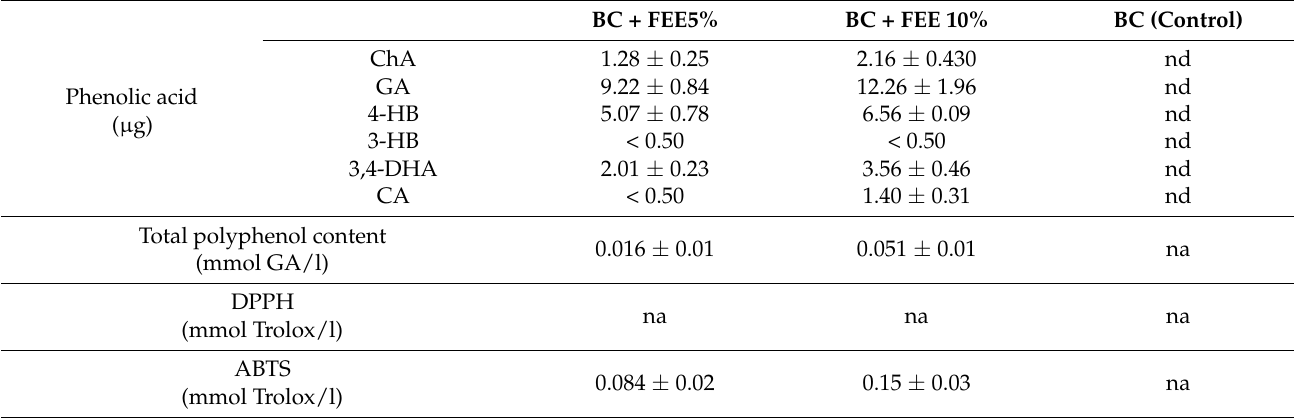
Figure 7. Optical microscopy images of L929 cells after 24 h incubation with medium containing extracts from BC-5%FEE ( A ), BC-10%FEE ( B ), BC ( C ), and control ( D ). Table 5. Phenolic acid concentration, the total polyphenol content, and antioxidant activity in acceptor fluid after 24 h penetration. Mean ± standard deviation, n =